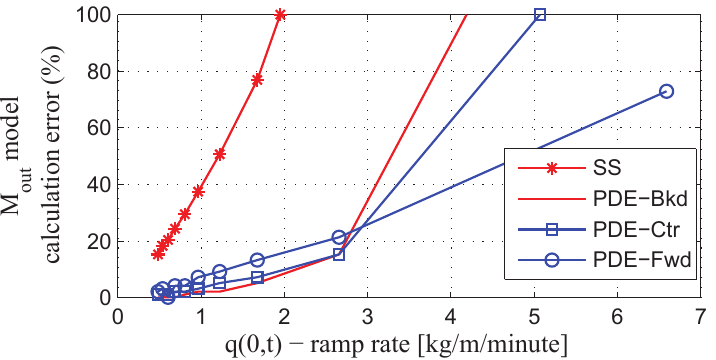
Figure 10. Effect of variation in q ( 0, t ) on the error when calculating M out .